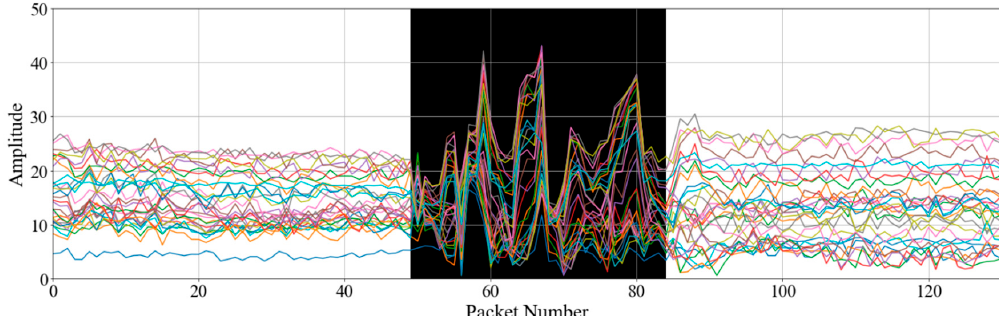
Figure 2. Raw CSI amplitude data of 30 subcarriers captured during walking. Colors indicate different subcarriers, and the black region indicates the walking activity.